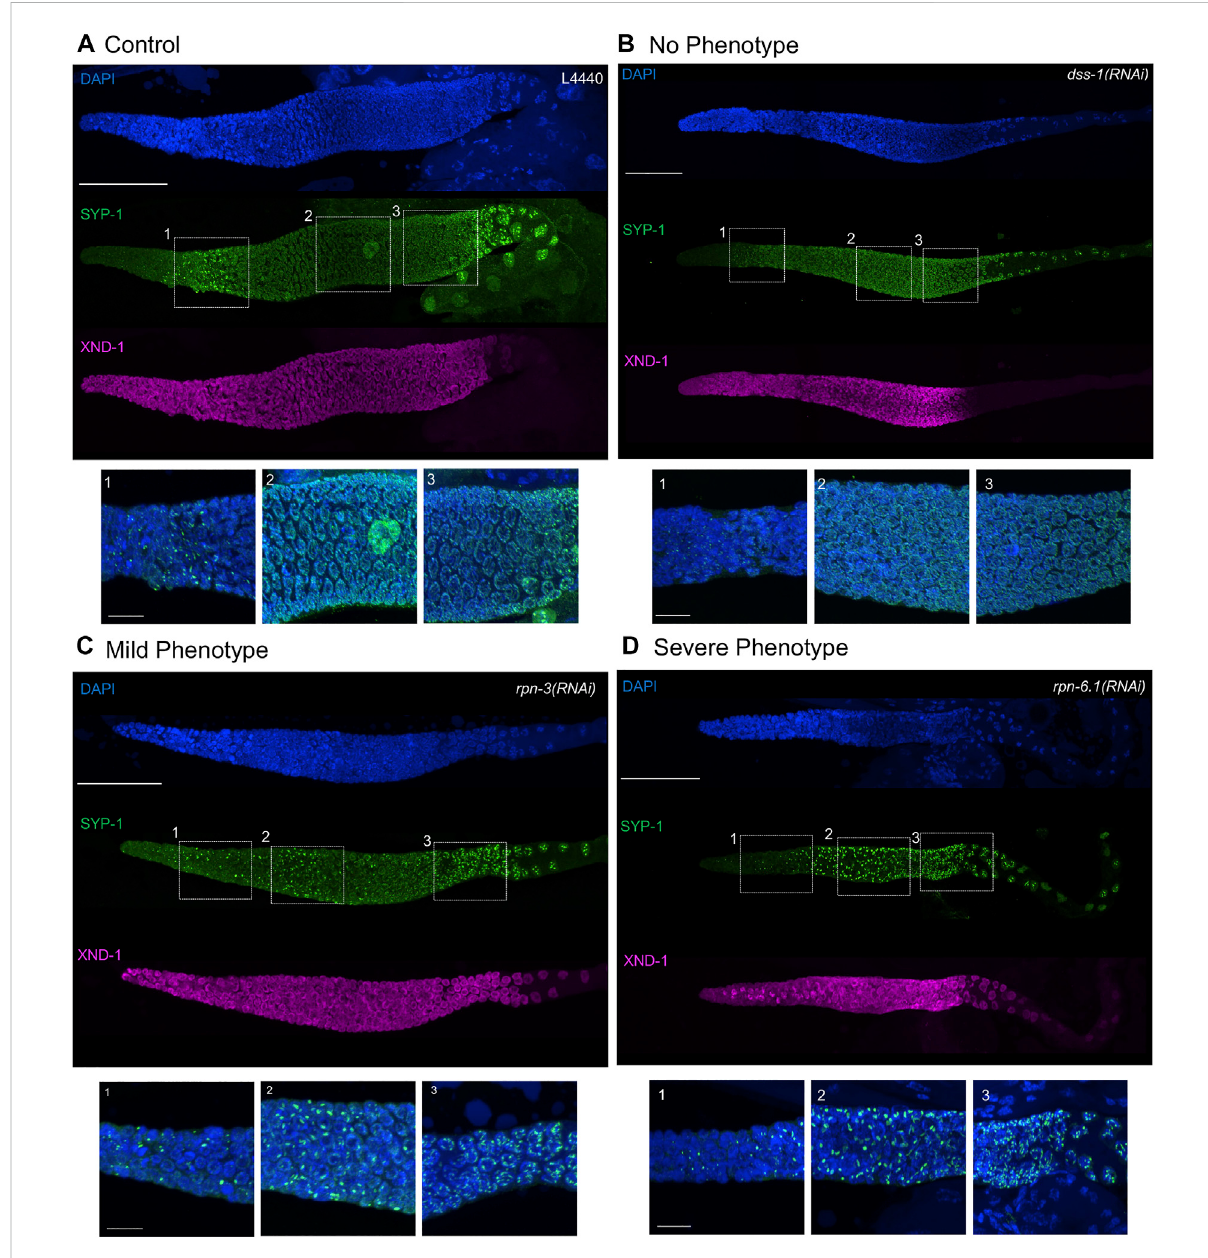
FIGURE 4 Synaptonemal complex defects are observed upon knockdown of 19S proteasome subunits. Representative images of germ lines visualized withanti-SYP-1to markthesynaptonemalcomplex(green),anti-XND-1(purple),and DAPItomark DNA(blue). (A) Control, emptyvector,showsthe expected formation of a few SC polycomplexes (PCs) in the TZ. (B) No phenotype: full polymerization of SYP-1 throughout pachytene stage and correcttimingofpolarizationtotheshortarmofthechromosomeatdiplotenecomparabletocontrol. (C) Mild-phenotype:extendedregionof PCs reaching early pachytene, with an abundant number of nuclei with fully polymerized SC in mid-pachytene. Premature polarization is also observed. (D) Severe phenotype:extended region of PCs into mid-pachytene, with almost all nuclei having atleast one PC and no polymerization of SYP-1. Premature polarization of SYP-1 was present at late pachytene. Whole gonad scale bar, 50 m. Zoom in boxes correspond to: (1) Transition Zone, (2) Early-Mid Pachytene, (3) Late Pachytene. Scale bar, 10